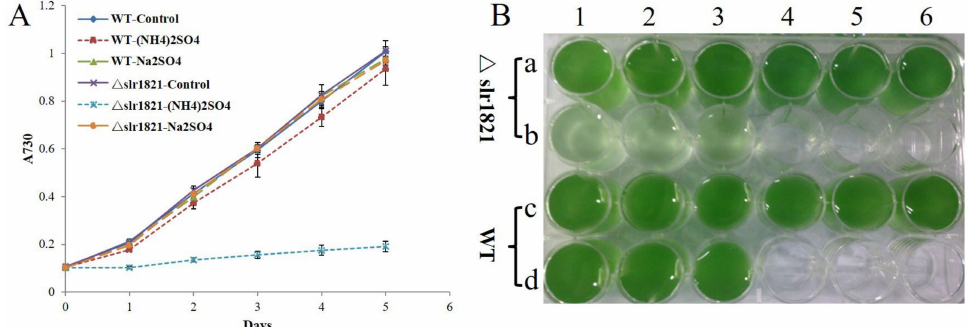
Figure 1. Functional Slr1821 is essential to the successful acclimation of Synechocystis 6803 to high con- centration of NH 4+ . ( A ) Wild type (WT) and ∆ slr1821 knockout mutant were grown in BG11 medium supplemented with 15 mM (NH 4 ) 2 SO 4 at 29 ◦ C under constant illumination of 25 µ mol · m − 2 · s − 1 . As normal control, WT and ∆ slr1821 were grown in normal BG11 medium. To eliminate the impact of SO 42 − , WT and ∆ slr1821 were grown in BG11 medium with 15 mM Na 2 SO 4 as background control. ( B ) The phenotype of WT and ∆ slr1821 on the fourth day in ( A ). a1, a2, a3 and c1, c2, c3 were ∆ slr1821 and WT in BG11 medium, respectively. a4, a5, a6 and c4, c5, c6 were ∆ slr1821 and WT in BG11-Na 2 SO 4 , respectively. b1, b2, b3 and d1, d2, d3 were ∆ slr1821 and WT in BG11-(NH 4 ) 2 SO 4 ,